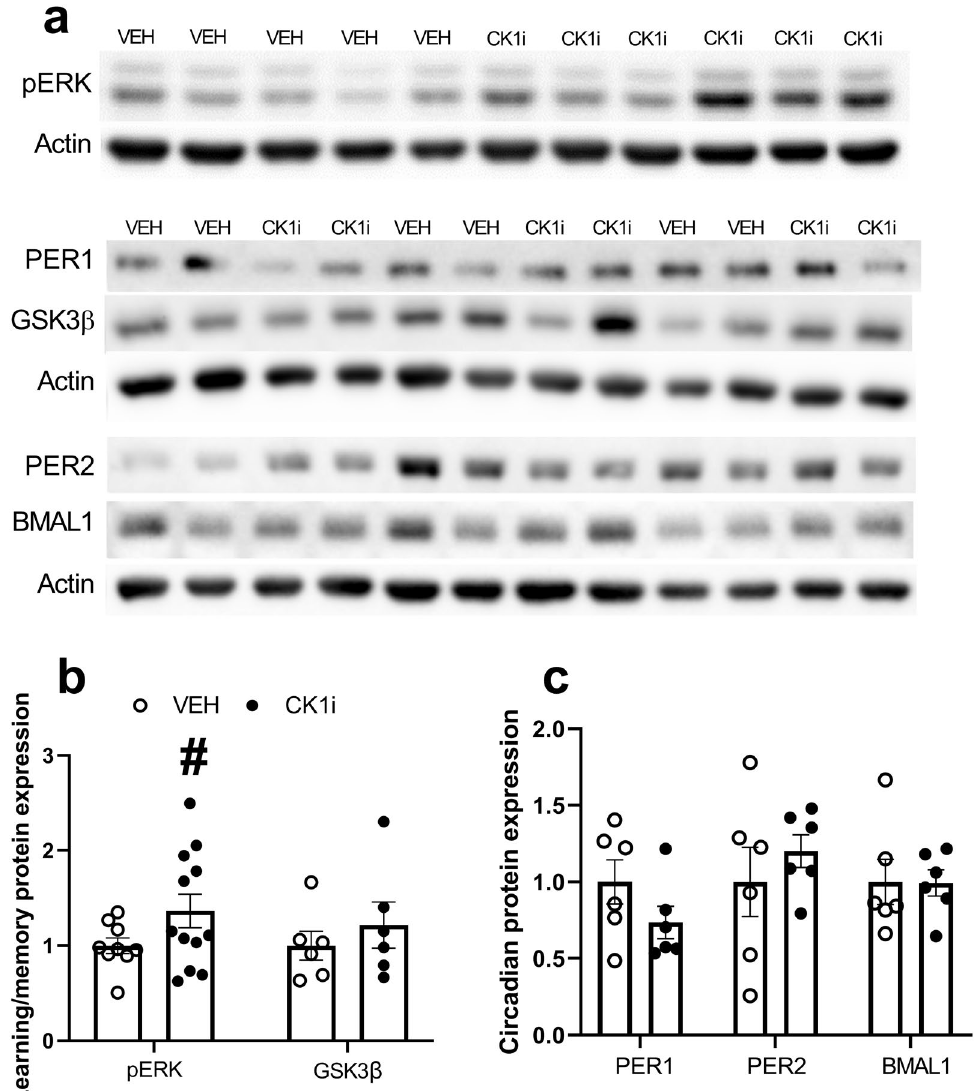
Figure 5. CK1 inhibition may increase pERK expression in the hippocampus. ( a ) Western blots for hippocampal pERK, PER1, GSK3β, PER2, BMAL1, and corresponding β-actin. Representative blot images. Images have been cropped. Full length blot images in Supplementary Fig. S1A–F. Quantification of western blots for ( b ) pERK and GSK3β. pERK results represent two separate normalized gels. ( c ) PER1, PER2, and BMAL1. Bands were normalized to actin, and expressed as fold change from vehicle group mean. Each dot represents result from one mouse. Data are represented as mean ± SEM. # p =